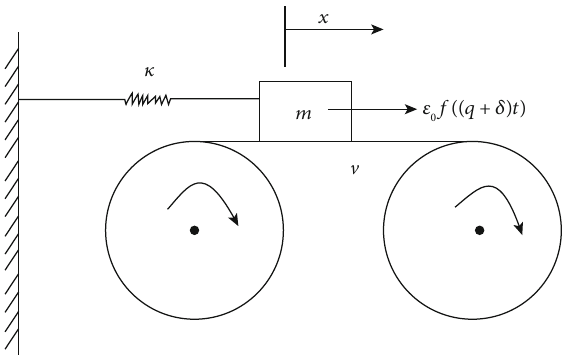
Figure 1: Schematic diagram of the dynamic model in Ref. of the order of σ ð q − 2 Þ /2 . Shilnikov et al. [8] and Iooss [9] com- puted the Arnold tongue in weak resonance case for the pla- nar map. The Neimark-Sacker bifurcation of an oscillator with dry friction was observed in Ref. [1]. Periodic-impact motions and bifurcations of vibroimpact systems near the 1 : 4 strong resonance point are considered in Ref. [10].